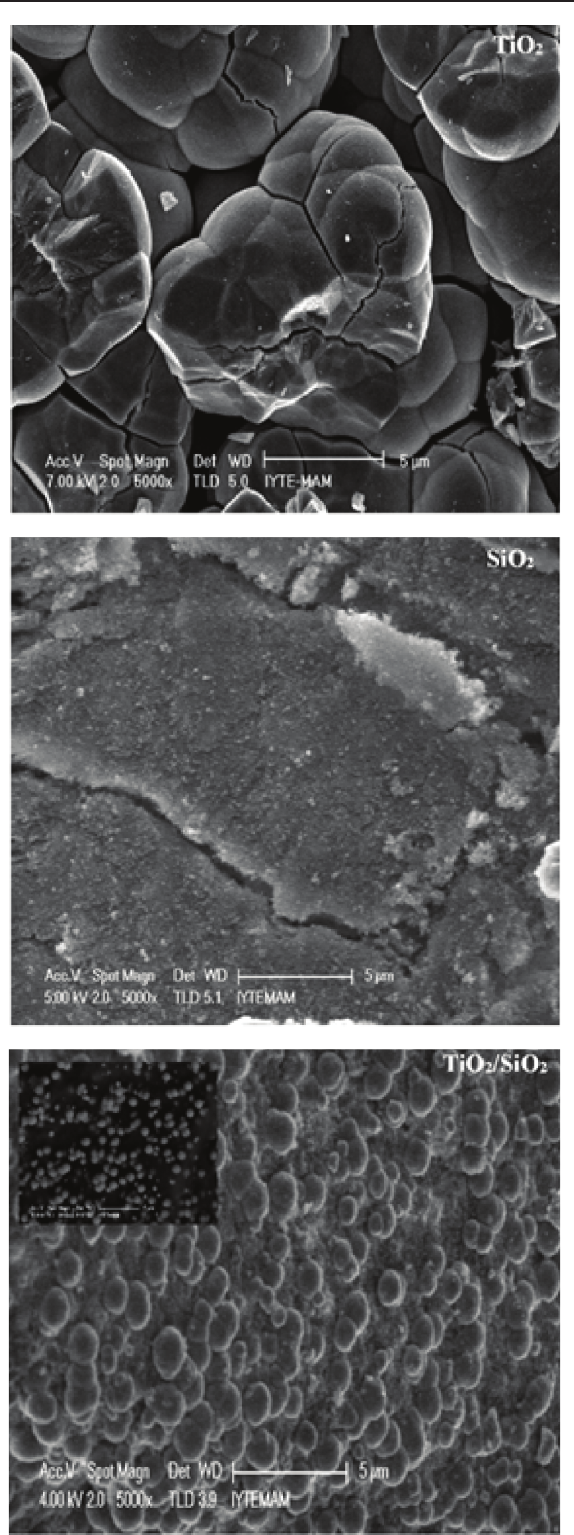
Fig. 1 – SEM images of the nanostructures (BSE image of TiO